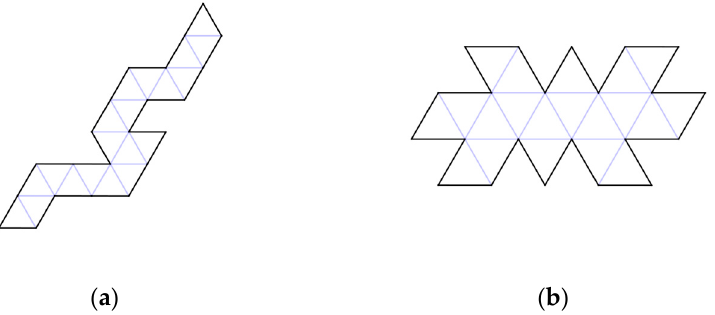
Figure 5. Of the 43,380 configurations of Dürer nets, we challenge the reader to time themselves in folding five different Dürer nets (1, 5a, 5b, 15, 16d). Consider: When do previous gluings make it difficult to make subsequent gluings? How difficult are the last few joinings to enclose the icosahe- dra?